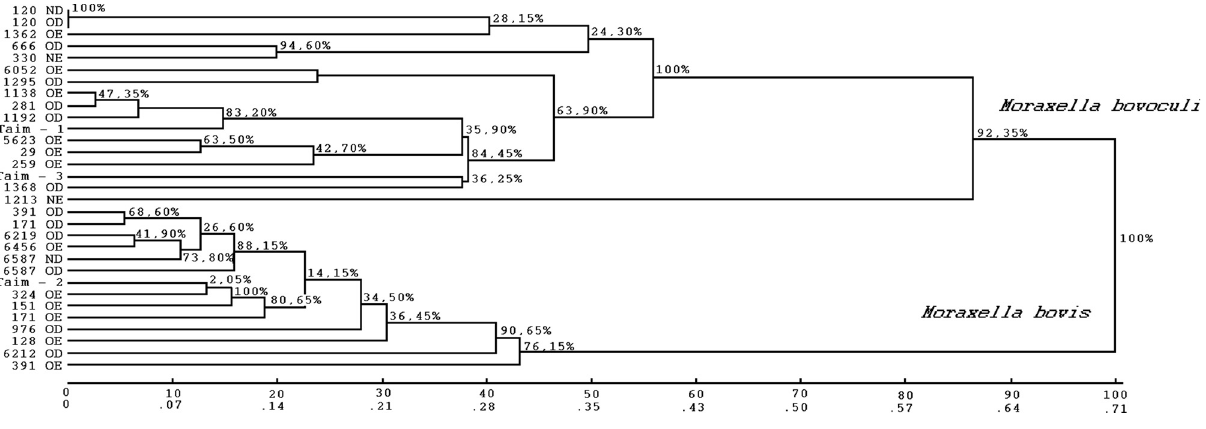
Figure 2 - Dendrogram representing the genetic relationships between M. bovis and M. bovoculi isolates by the UPGMA method. Bootstrap values repre- sented in the tree (2000 bootstrap repetitions).